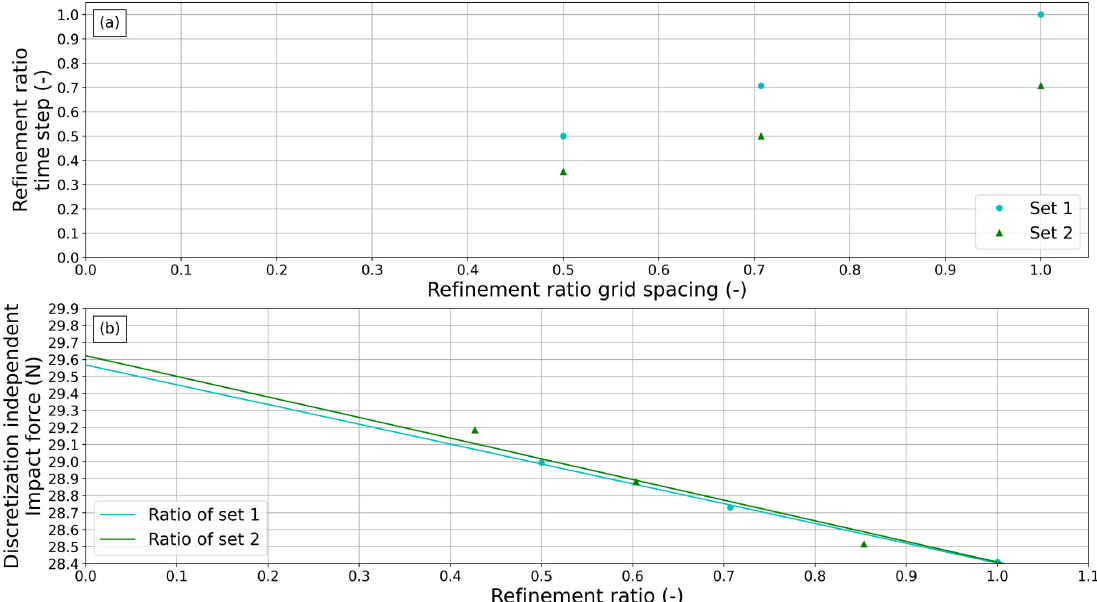
Figure 5. Time step refinement ratio versus grid spacing refinement ratio ( a ) and grid spacing and time step independent longitudinal impact load versus the arithmetic mean of the x ij and y ij ( b ) based on the laminar flow model.